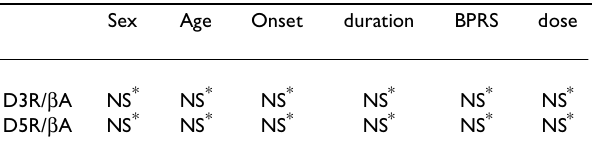
Table 3: Influence of clinical factors on D3R/ β A, D5R/ β A mRNA ratio in drug-med patients